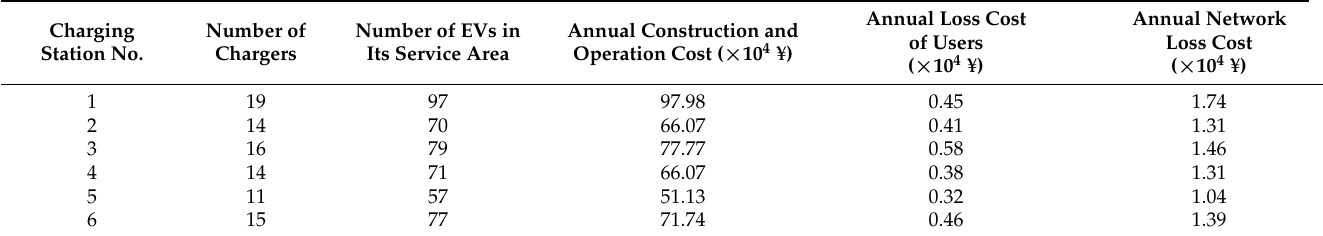
Figure 4. Charging stations’ locations and their service areas obtained by IPSO and Voronoi diagram. Table 1. Optimal planning result of charging